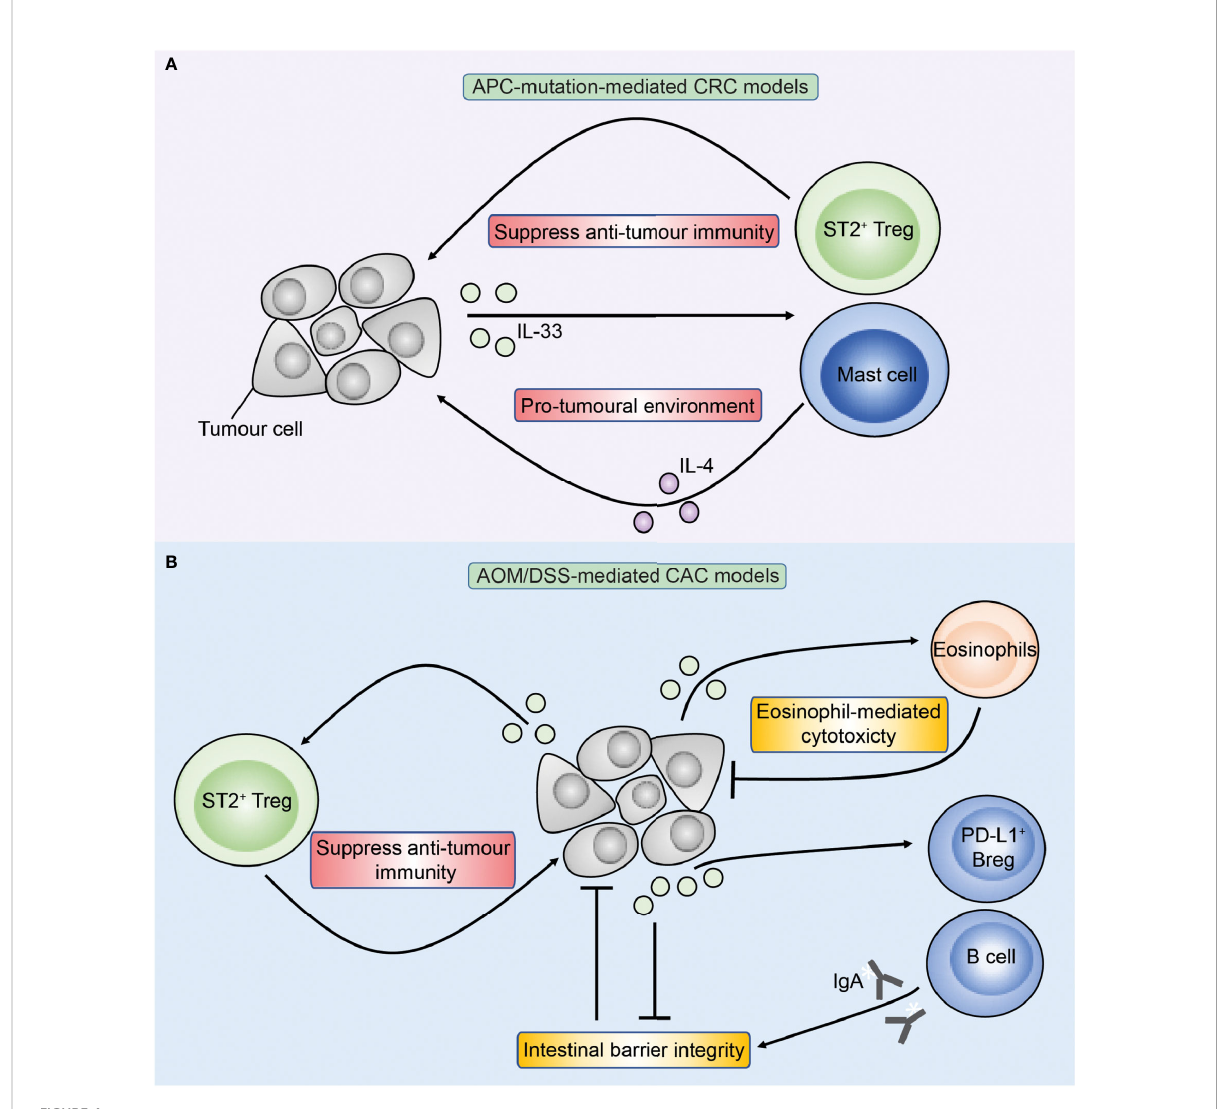
FIGURE 4 Overview of IL-33 in APC-mutation-mediated CRC and colitis-associated cancer (CAC) models. Figure depicts the role of IL-33 in preclinical models of APC-mutation-mediated CRC (A) and CAC (B) . (A) In APC-mutation-mediated CRC models, IL-33 is proposed to promote tumorigenesis through activating ST2 + Tregs and mast cells which may have pro-tumoral properties through suppressing anti-tumour T cells and production of IL-4 respectively. (B) In AOM/DSS-mediated models of CAC, IL-33 can similarly promote tumorigenesis through ST2 + Tregs, but also via direct action on ST2 + epithelial tumour cells compromising the intestinal barrier resulting in colitis and CAC. Conversely, IL-33 may inhibit CAC through sustaining intestinal barrier integrity via stimulating B cells to produce IgA, and also via direct activation of anti-tumoral